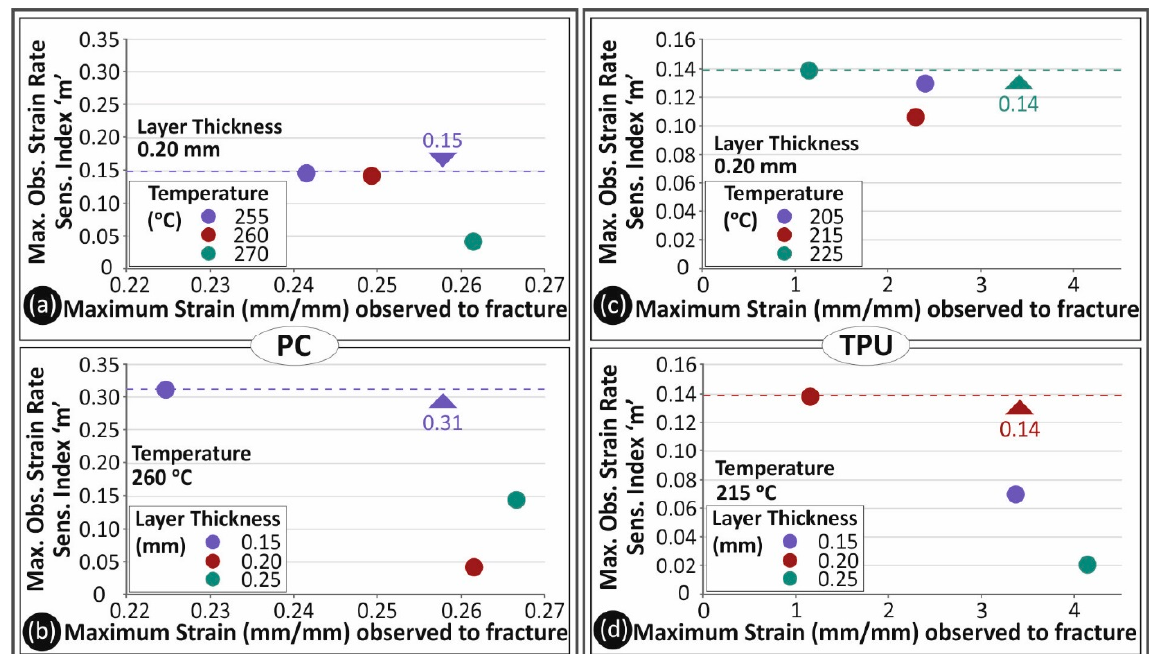
Figure 14. Maximum observed strain rate index ‘m’ to maximum strain observed at break (mm/mm) for PC ( a , b ) and TPU ( c , d ) materials for the different temperatures ( a , c ) and the different layer heights ( b , d ) studied in this work.